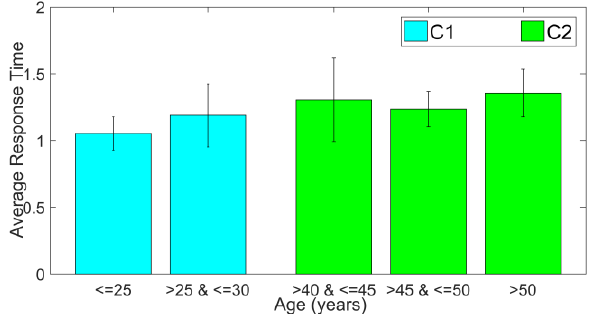
Fig. 6 Average response time for dDSST version 1